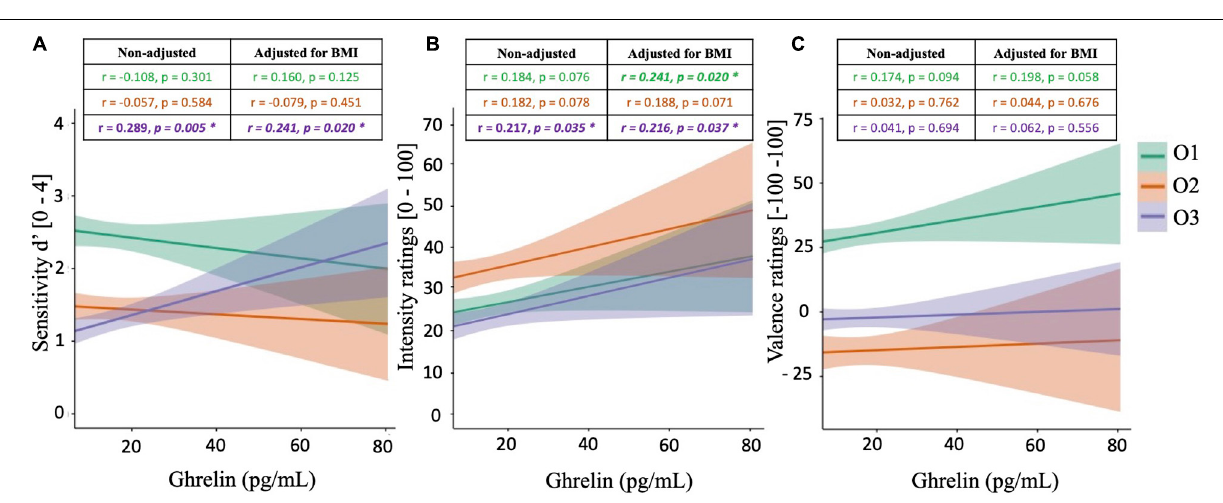
FIGURE 3 | Correlation plots between peripheral ghrelin levels and olfactory supra-threshold sensitivity (A) , olfactory intensity ratings (B) , and olfactory valence ratings (C) of the odorants O1 (vanilla odour), O2 (potato odour), and O3 (dairy odour). All graphical plots illustrate results obtained from Pearson’s correlations (non-adjusted). Significant results are represented by ∗